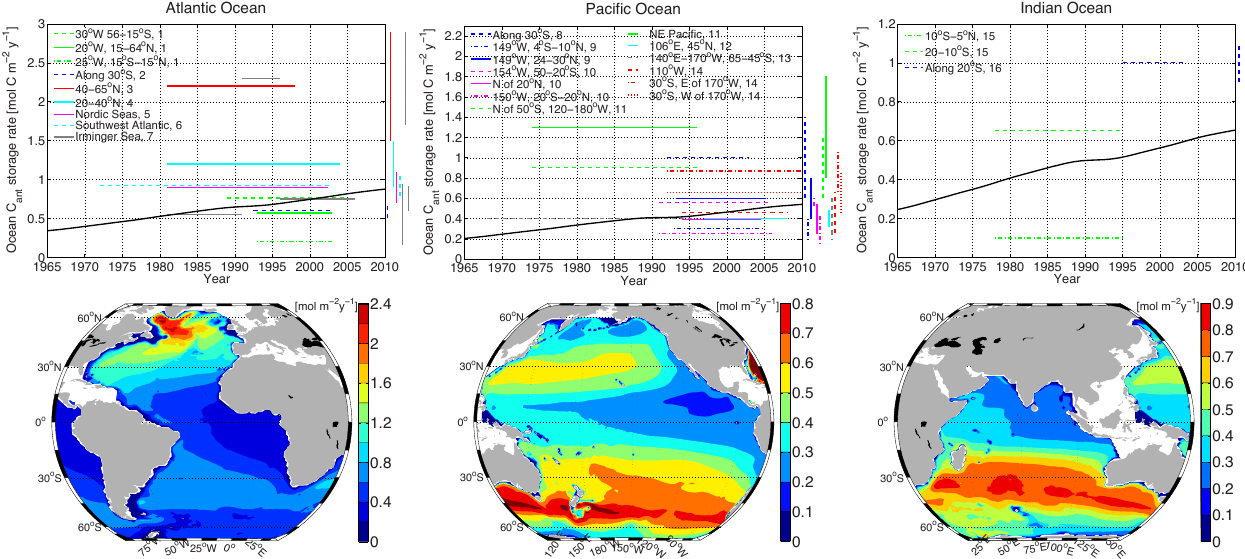
Fig. 7. Storage rates of anthropogenic carbon ([mol m − 2 y − 1 ]) for the Atlantic (left), Pacific (center), and Indian Ocean (right), based on repeat hydrography (top) and the GF inversion (bottom). Measurements for the northern hemisphere are drawn as solid lines, the tropics as dash-dotted lines, and dashed lines for the southern hemisphere; the color schemes refer to different studies. Solid black line in each panel is the time-varying basin mean storage rate estimated by the Green function approach (Khatiwala et al., 2009). Estimates of uncertainties are shown as vertical bars with matching colors. Maps on bottom show the corresponding storage rate distribution from the GF inversion averaged over 1980–2005. Data sources are as indicated in the legend are: 1) Wanninkhof et al. (2010), 2) Murata et al. (2008), 3) Friis et al. (2005), 4) Tanhua et al. (2007), 5) Olsen et al. (2006), 6) R´ıos et al. (2012), 7) P´erez et al. (2008), 8) Murata et al. (2007), 9) Murata et al. (2009), 10) Sabine et al. (2008), 11) Peng et al. (2003), 12) Wakita et al. (2010), 13) Matear and McNeil (2003), 14) Waters et al. (2011), 15) Peng et al. (1998), and 16) Murata et al. (2010).